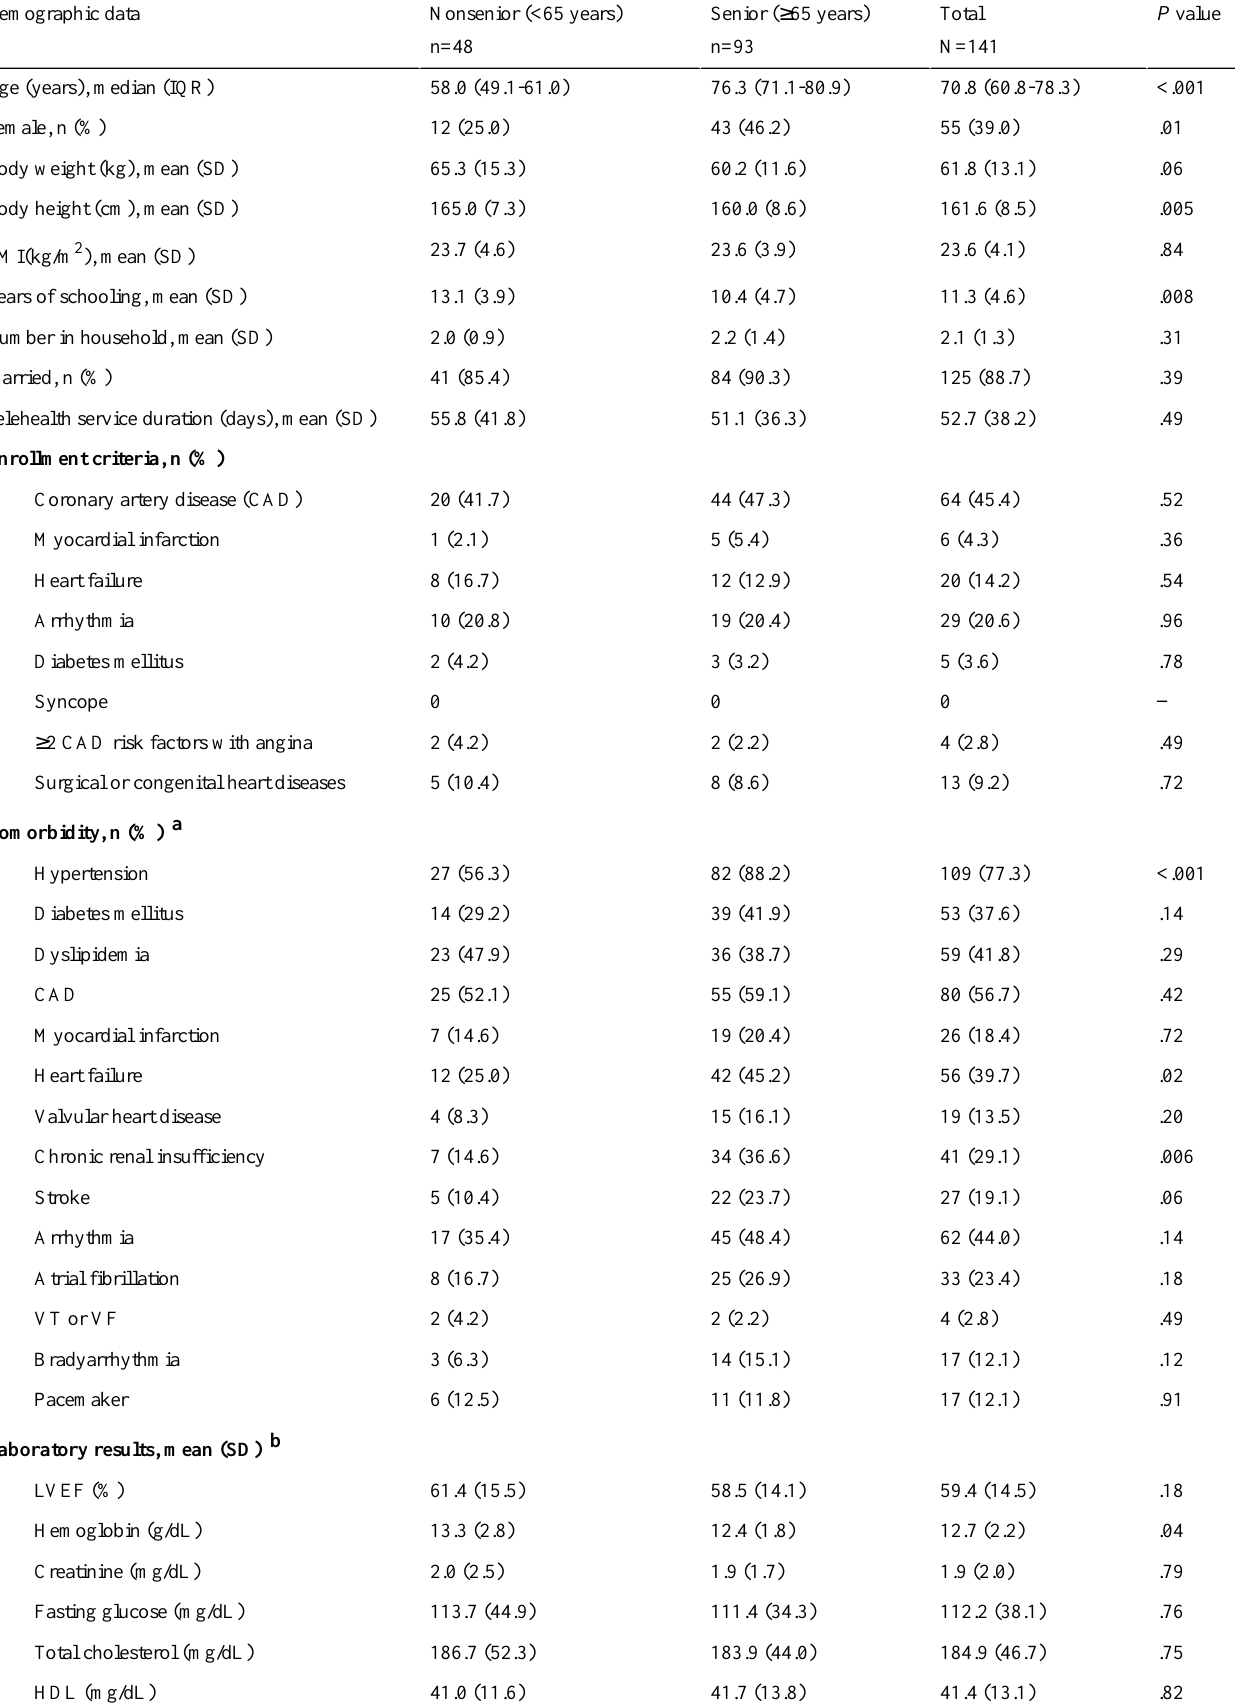
Table 1. Baseline demographic data for patients with cardiovascular disease receiving telehealth